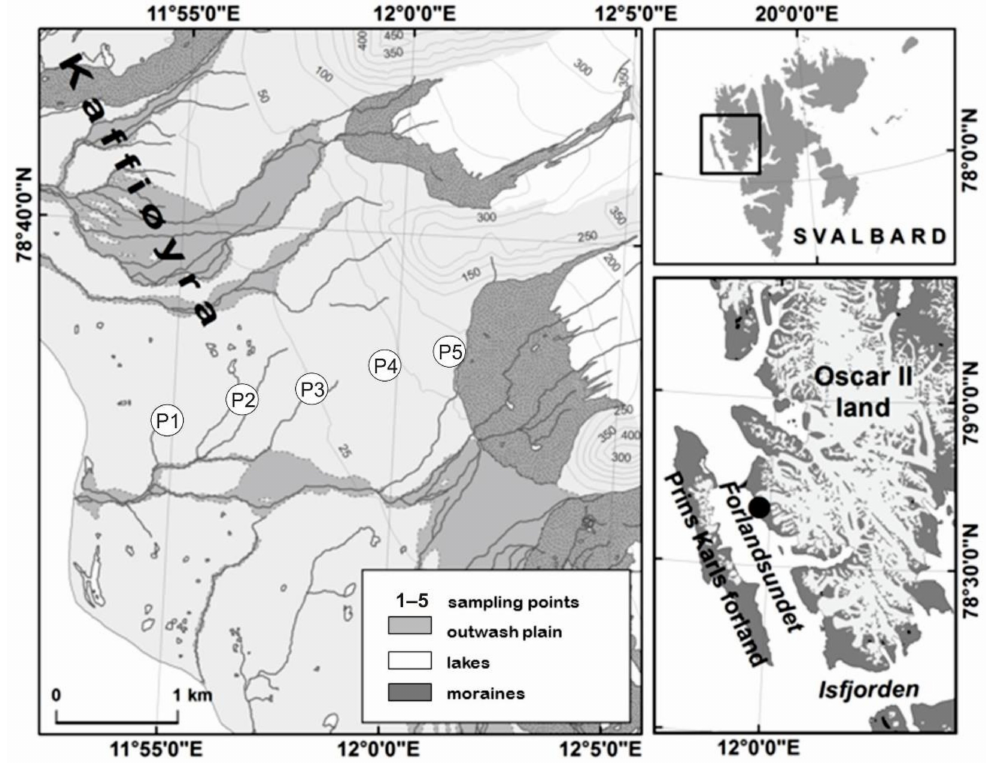
Figure 1. Location of studied soil profiles